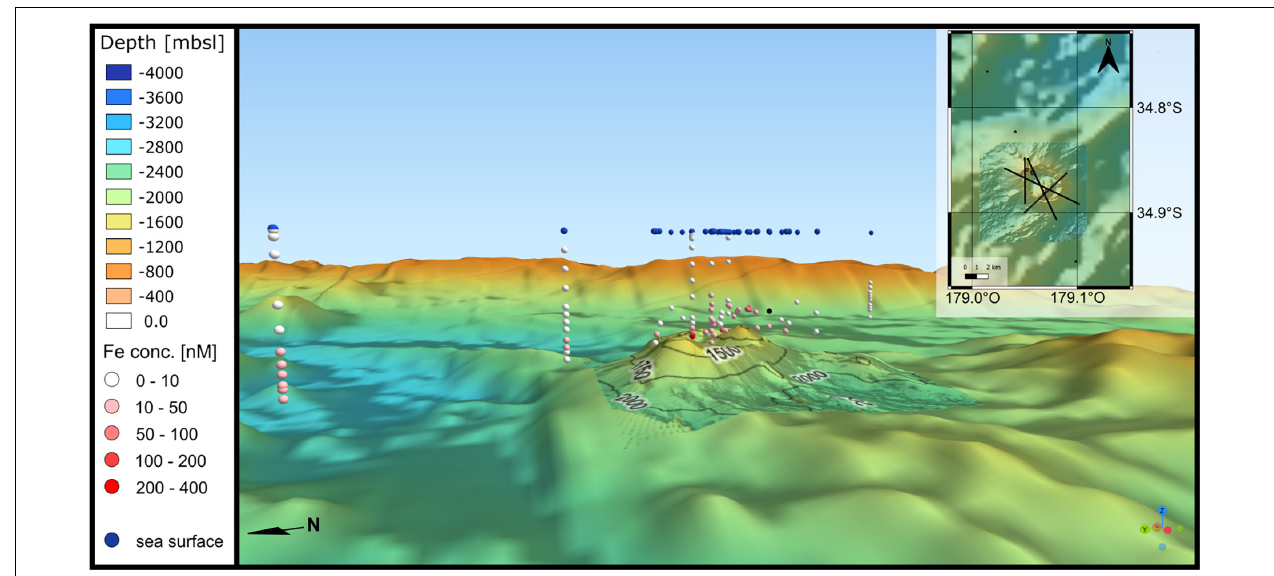
FIGURE 3 | Example screenshot (Brothers, distribution of Fe) of the 3-D model for all discussed trace metals during this study for both volcanoes. The black dots in the small figure on the right show the CTDs and TMRs, while the black lines refer to the conducted tow-yos. mbsl: m below sea level.